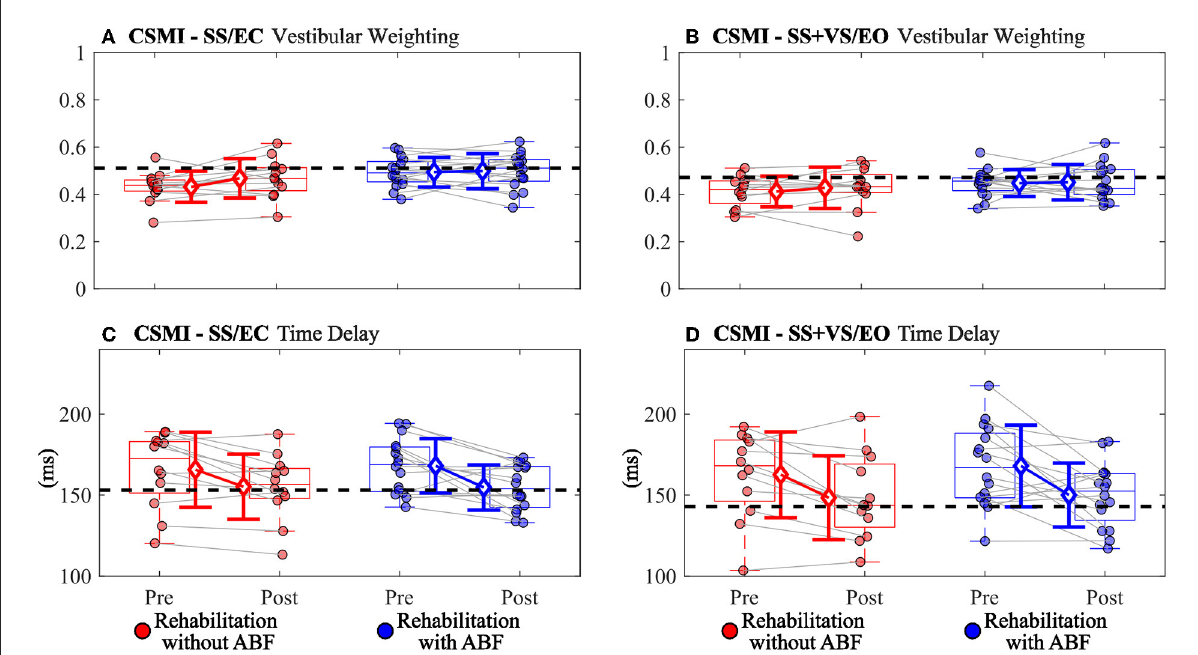
FIGURE2 Individual participant data pre- and post-rehabilitation for groups without audio biofeedback (ABF—red) and with ABF (blue) for (A) vestibular weighting during surface-tilt with eyes closed (SS/EC), (B) vestibular weighting during combined surface-tilt and visual-tilt with eyes open (SS + VS/EO), (C) time delay during SS/EC, and (D) time delay during SS + VS/EO. Central box shows median (center line) with upper and lower quartiles defined by 0.75 quantile and 0.25 quantile values, respectively. Whiskers extend to maximum and minimum values that are not considered outliers. Mean group values are indicated by open diamonds with + /- 1 standard deviations. Gray lines connect individual participant data. Blacked dashed horizontal line indicates mean value derived from control subjects in Supplementary material from Peterka et al. (9). Values moving toward the healthy control mean value indicate improved